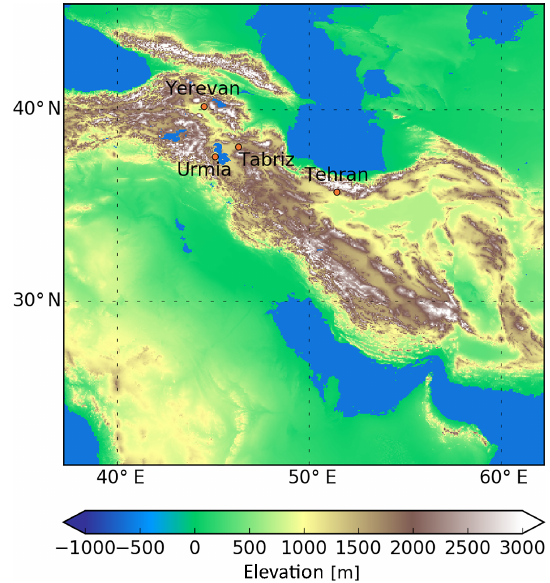
Figure 1. Topological map of the model domain taken form the 2000 Shuttle Radar Topography Mission (SRTM) data with a reso- lution of 15arcsec (Farr et al., 2007). An analogous terrain height is used for the WRF simulation. The cities of Yerevan, Urmia, Tabriz, and Tehran with CO hot spots are marked in the